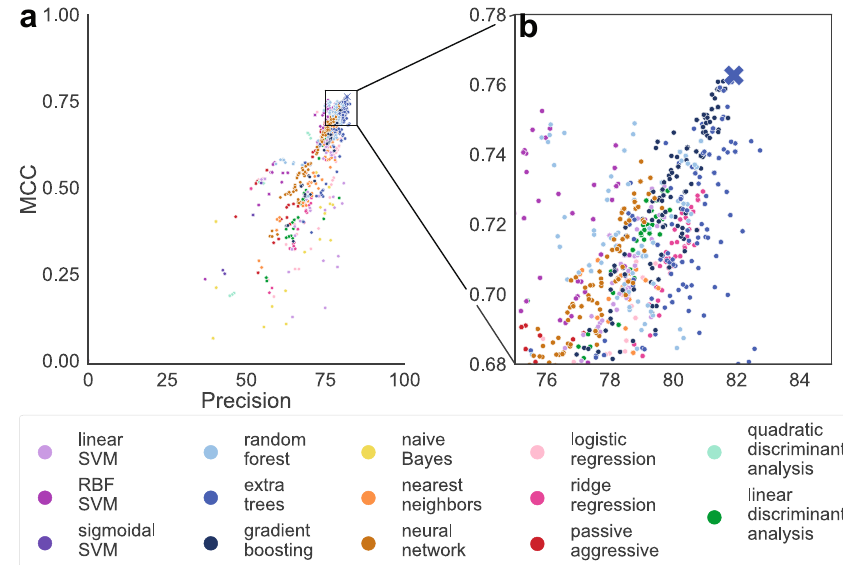
Fig. 3 Outer CV performance by the algorithm. a Each point represents the results for a speci fi c model. Points are colored according to the algorithm used and grouped by classi fi er type; support vector machines (SVMs) are purples, decision-tree ensemble methods are blues, linear models are reds, discriminant analysis is greens, no grouping for naive Bayes, nearest neighbor, and neural network. Better performing classi fi ers should be close to the upper right corner. The X denotes our top model (extra trees with AllMeanSph feature set). b Zoomed-in view of boxed region in ( a